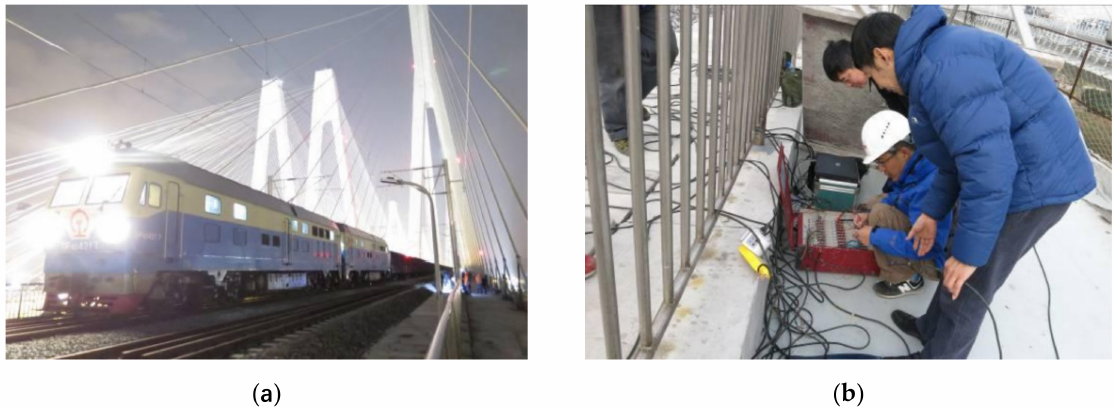
Figure 9. Photos of in situ test: ( a ) the loading train and ( b ) the instrumentation and data acquisi- tion